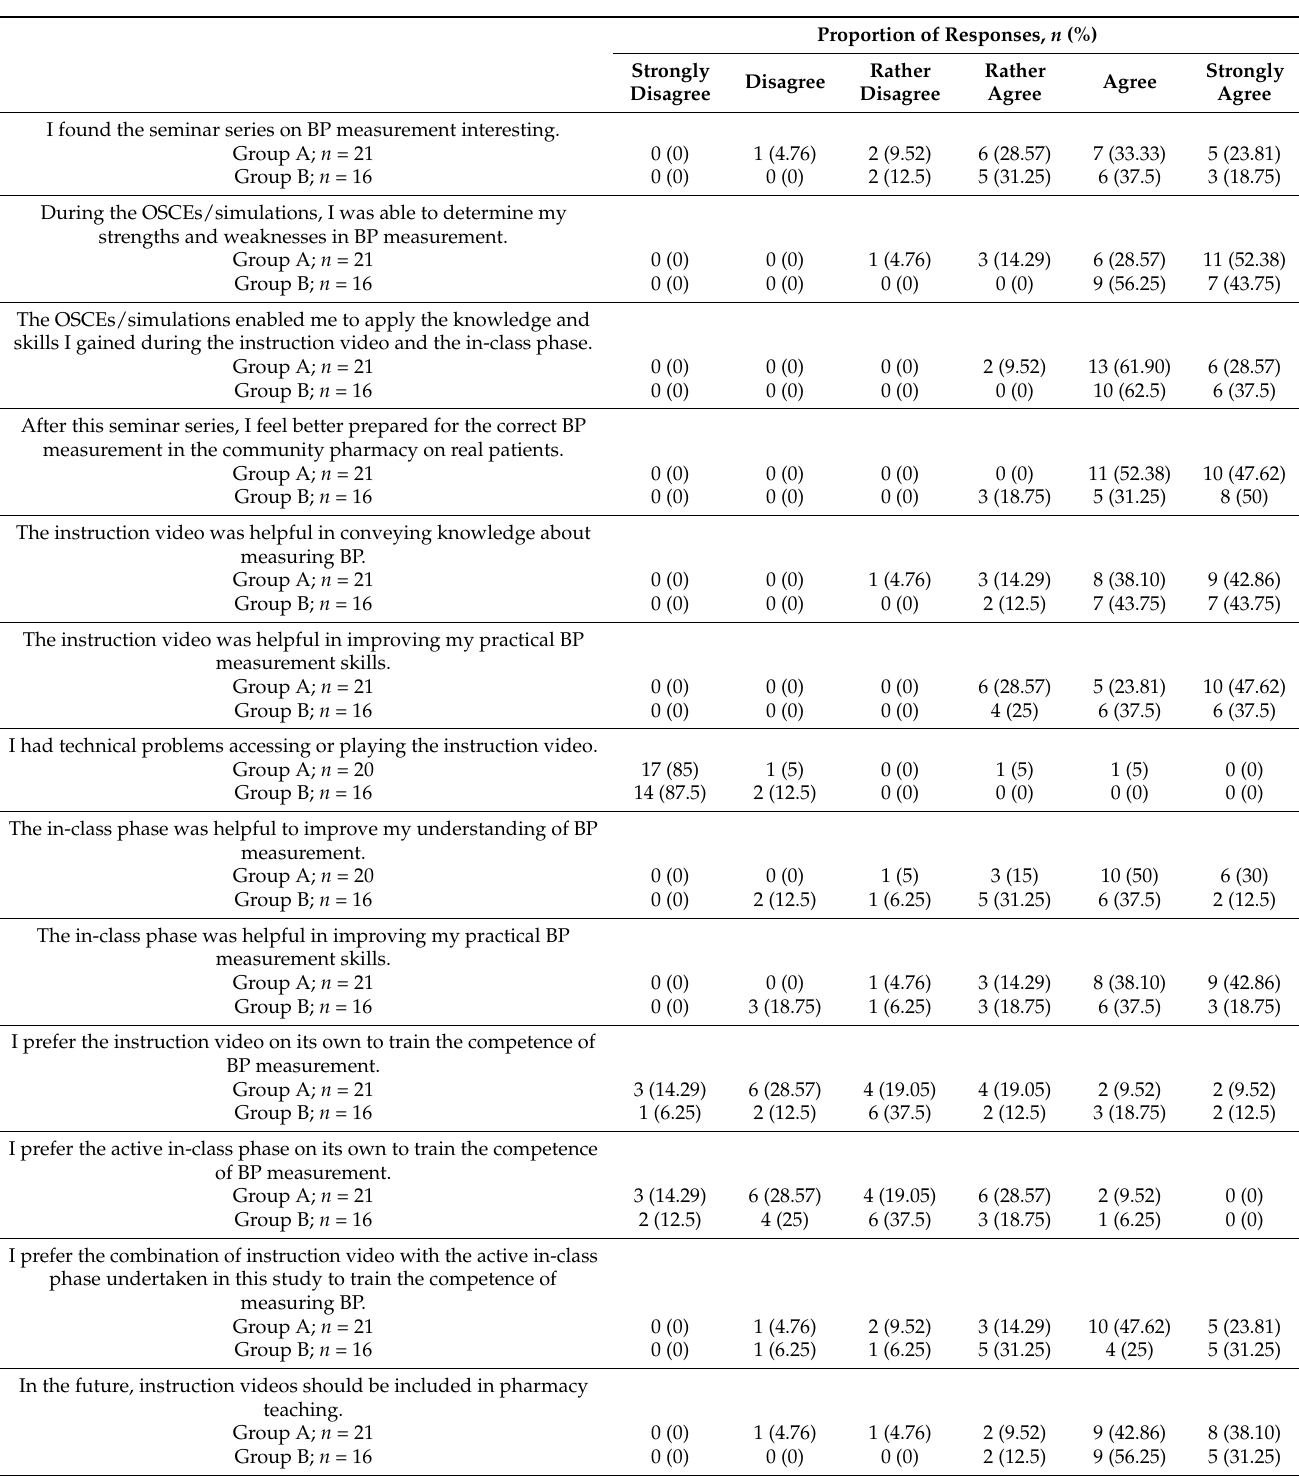
Table 3. Results of the perception and satisfaction survey.